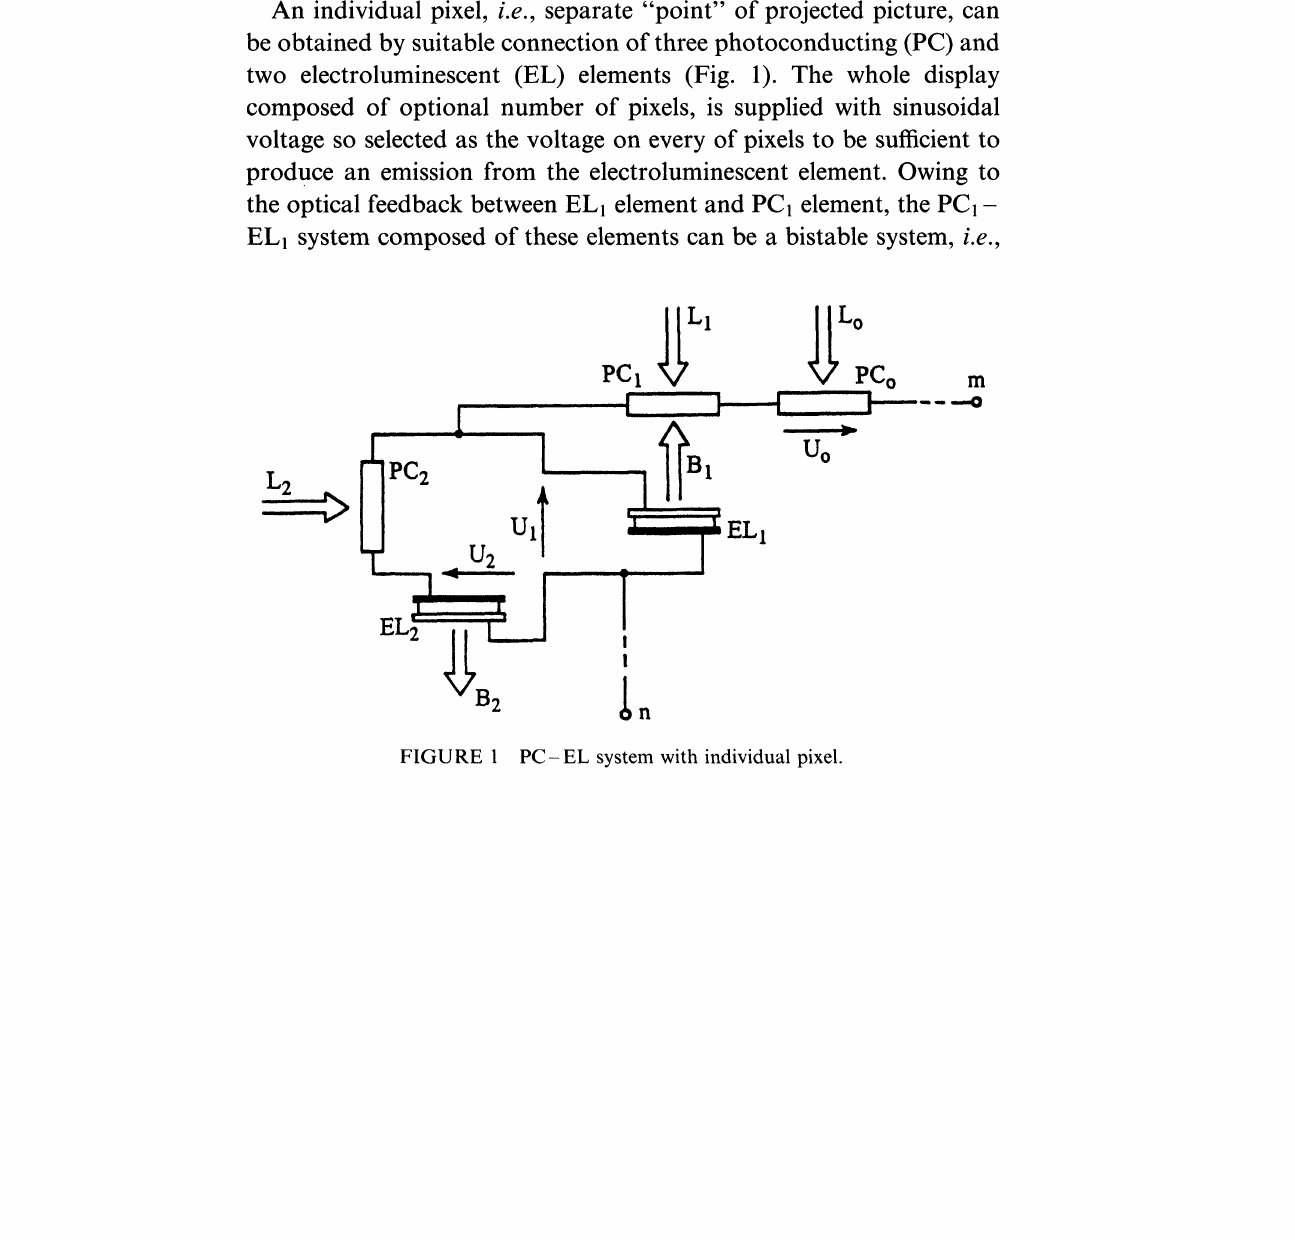
FIGURE PC-EL system with individual